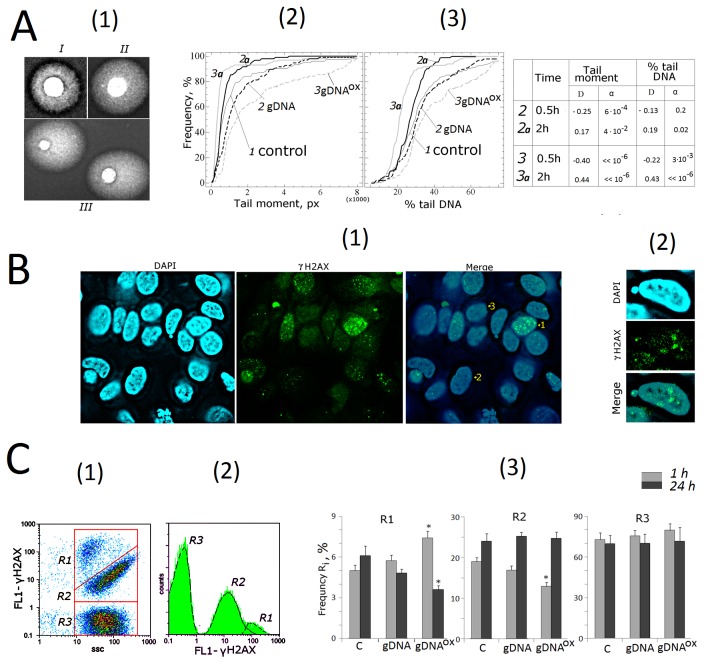
DNA damage in cells exposed to either gDNA or gDNAOX at final concentration 50 ng/mL for 30 min and 2 hours.А – comet assay in alkaline conditions [1]. - Digital photography of the nuclei with varying degree of DNA damage [2,3]; - cumulative histograms for tail moment and percentage of DNA within tails. The reliability of differences with the control in the obtained distributions was analyzed by means of Kolmogorov–Smirnov statistics (the table shows the values of D and α).B - dsDNA breaks in cells exposed to gDNAOX (50ng/mL, 1 hour).Cells were processed for immunofluorescence staining with anti γH2AX antibody (x40) [1].- Three detected types of nuclei are denoted by numbers: 1- nucleus with multiple dsDNA breaks, 2- nucleus with a few dsDNA breaks, 3- nucleus with intact DNA [2]. - Example of a micronucleus with dsDNA breaks.С – FACS analysis of γ-foci A: there main fractions of the cells as evident in gating areas R1, R2, R3 [1], the distribution of γH2AX fluorescence intensities [2], relative proportions of cells within gating areas R1-R3 [3]. *p < 0.05 against control group of cells, non-parametric U-test.